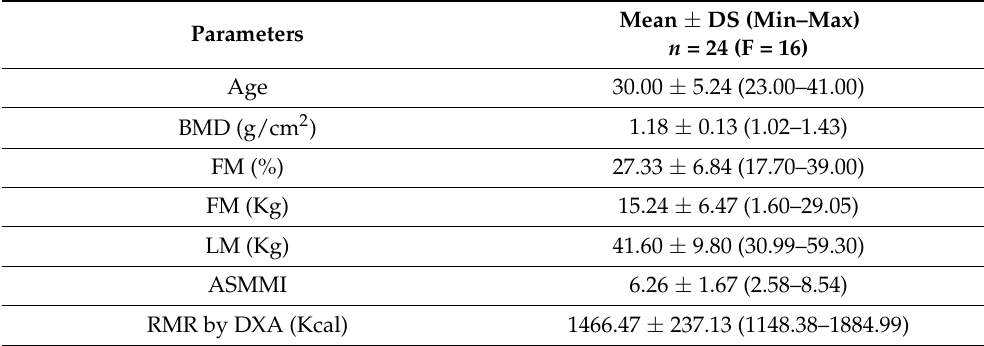
Table 1. Baseline body composition evaluation of the participants at the beginning of the